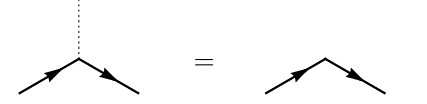
= Figure 20 . Removal of a trivial junction (with identity junction